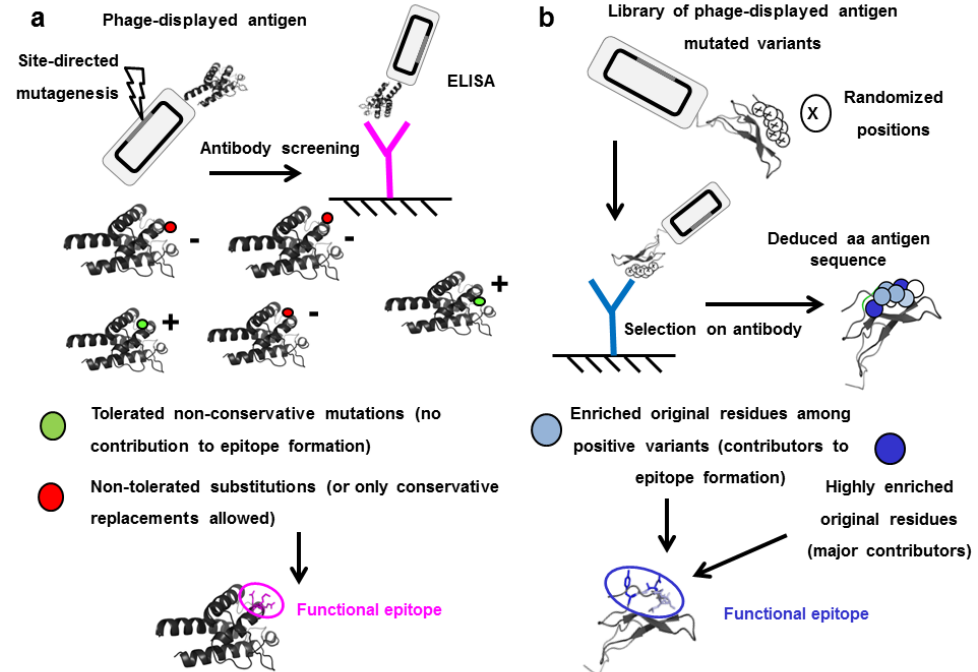
Figure 2. Epitope identification through mutagenesis scanning of the antigen surface. ( a ) Phage-displayed antigen is diversified through site-directed mutagenesis targeting a candidate antigenic area previously identified. Single mutated variants are tested by ELISA with the antibody under investigation, and classified as positive or negative. Those positions that cannot be mutated without abolishing antigen recognition (or where only conservative replacements are accepted) are defined as functional contributors to the epitope. ( b ) Combinatorial mutagenesis within a candidate antigenic region results in construction of a library of multiple mutated antigen variants. Phage panning on an immobilized antibody leads to selection of recognized (positive) variants. Sequencing reveals that several original residues are enriched to different extents among them, and the whole cluster is thus identified as the functional epitope.